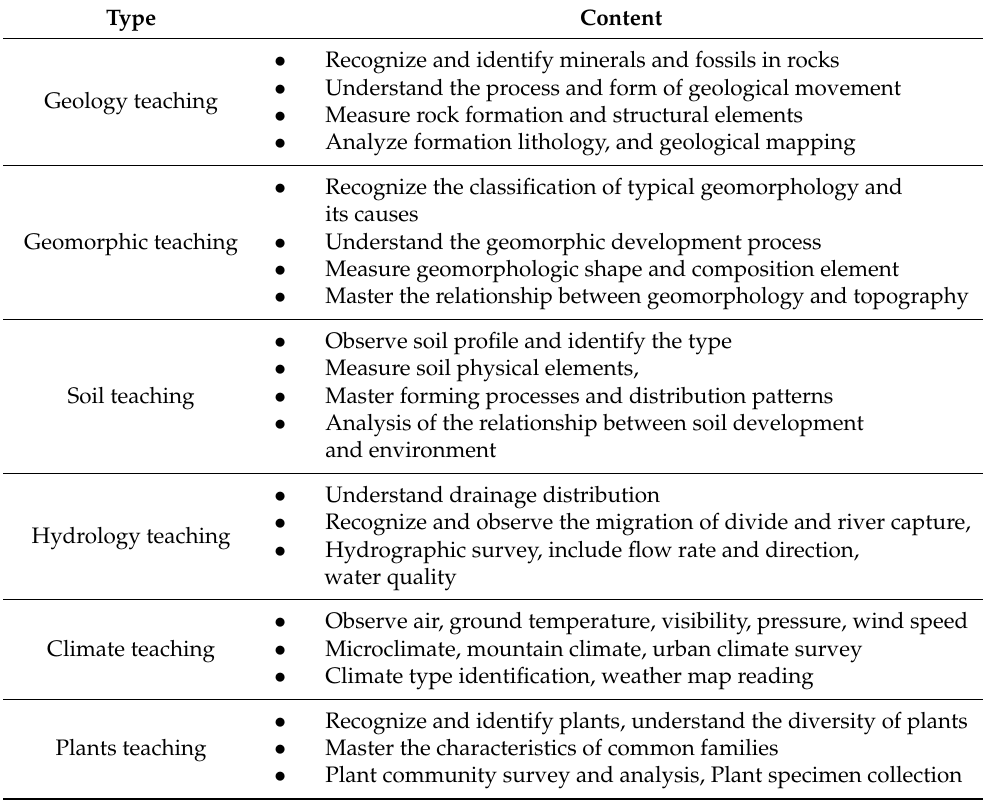
Table 1. Fieldwork teaching content in